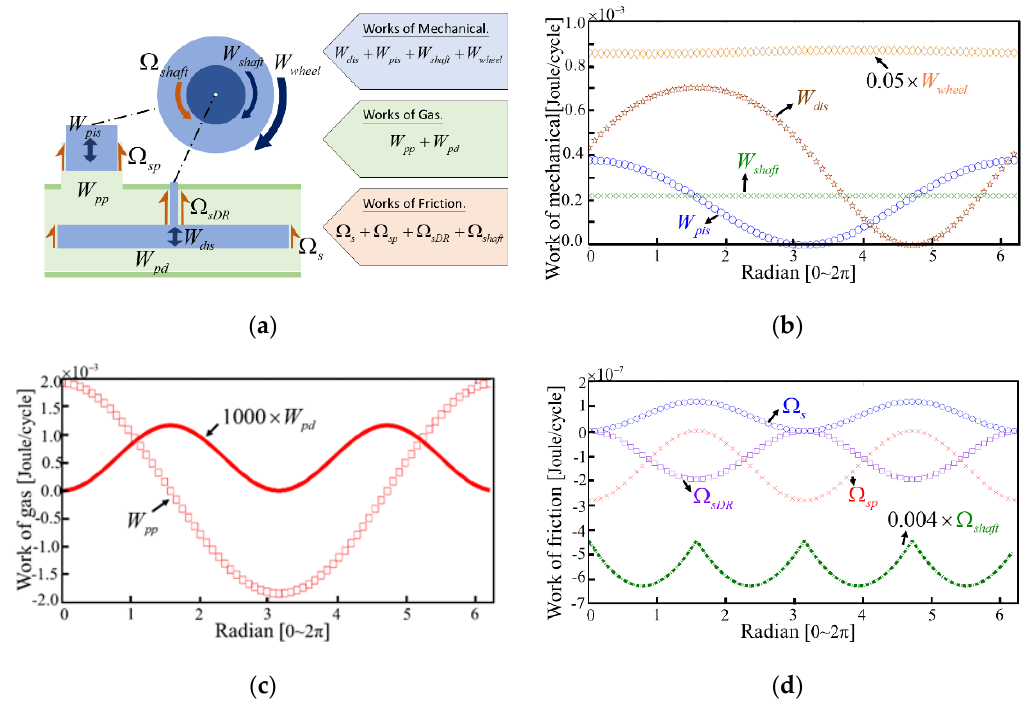
Figure 8. Distribution of work from the heat source in one cycle of the gamma-type Stirling engine. ( a ) Major components in the engine, ( b ) work values of the gas part, ( c ) work values of the mechanical part, and ( d ) work values of the friction part.